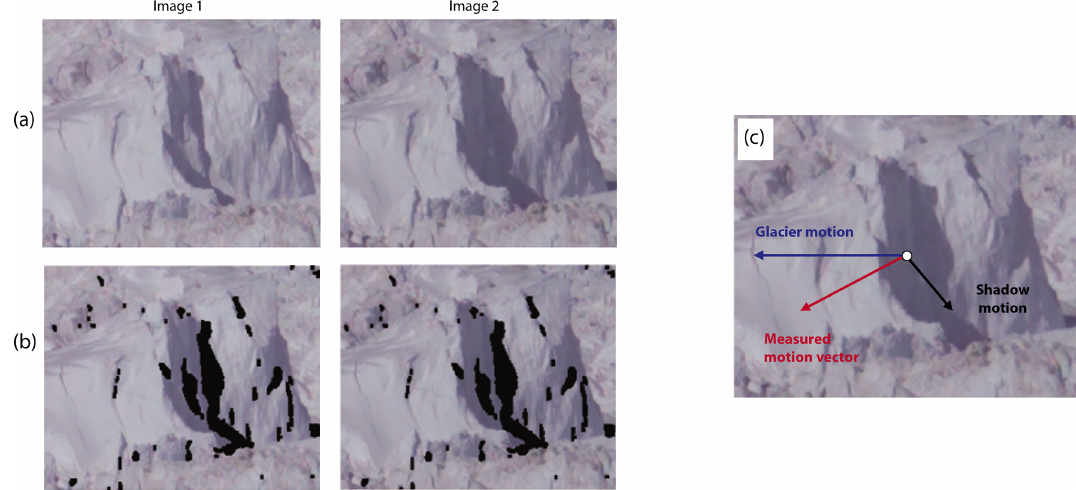
Figure 6. Influence of moving shadows in image sequences. The figure shows corresponding image sections from two sequence images recorded at a time interval of 30min (a) . In the same image pair those pixels were marked black which are influenced by shadow motion (b) . These pixels falsify the result of the feature tracking because the tracked glacier movement is overlaid by the shadow movement (c)